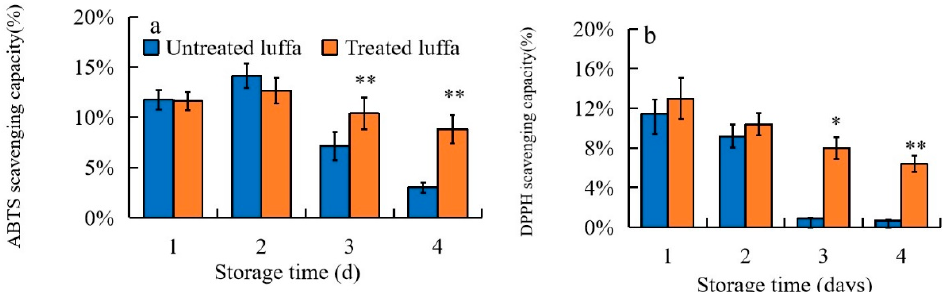
Figure 3. Effect of CaCl 2 treatment on ( a ) ABTS and ( b ) DPPH scavenging activity in fresh-cut luffa. Each value is presented as mean ± SE ( n = 3). ** and * represent extremely significant differences and significant differences, respectively ( p < 0.05 and p < 0.01, respectively). ABTS, 2,2 ′ -azino-bis-3-